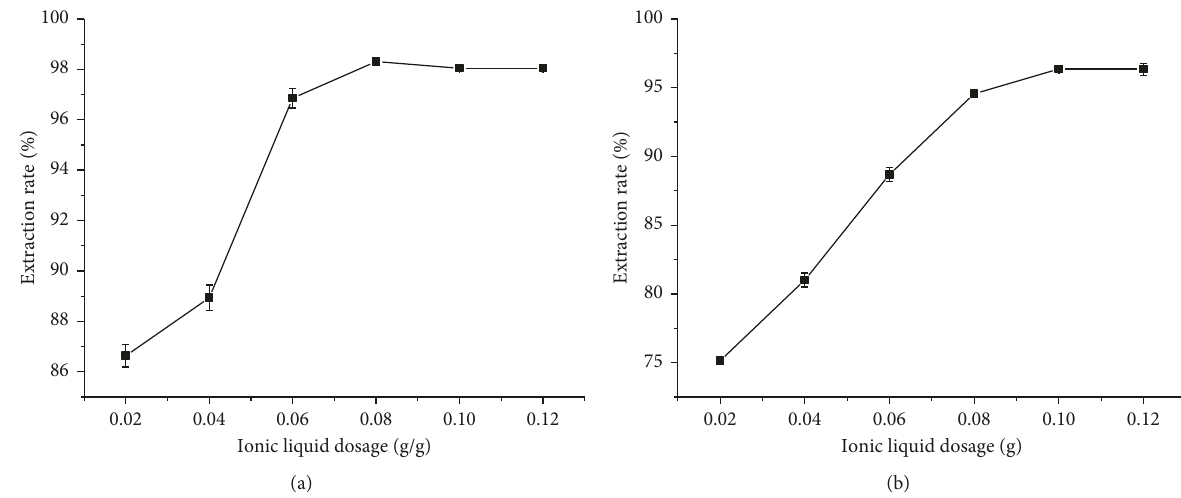
Figure 2: Effect of the amount of ionic liquids on extraction rate. (a) IL-1; (b) IL-2. The error bars represent the standard deviation of measurements in three parallel experiments ( n � 3).